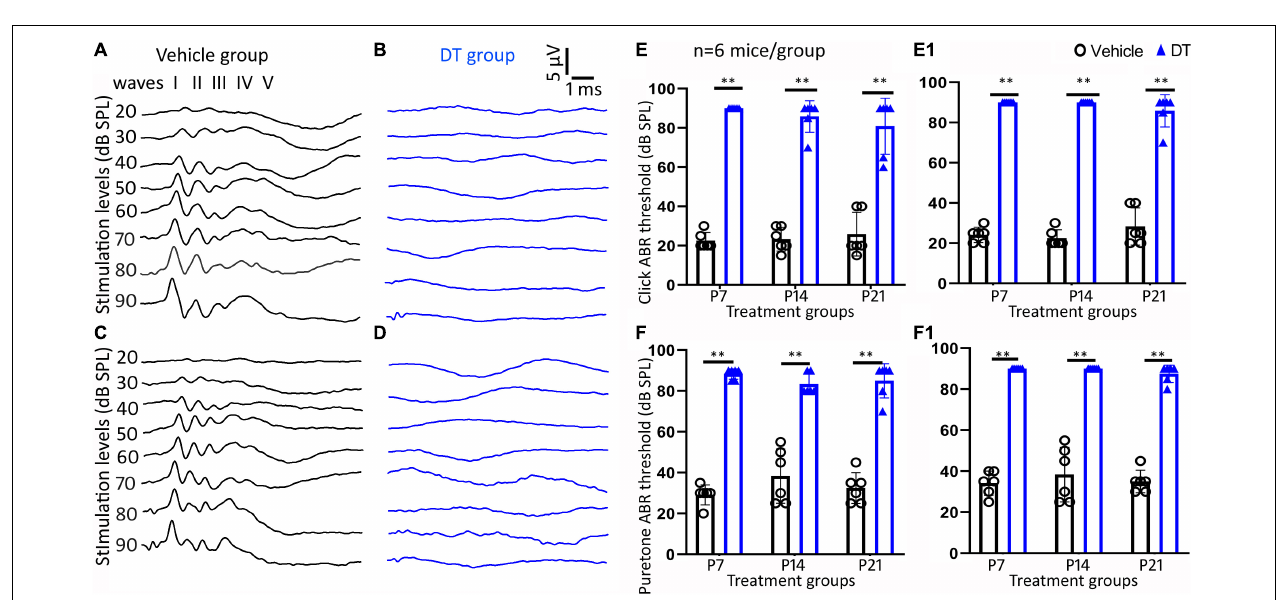
FIGURE 3 | Auditory brainstem response (ABR) measurement study. Representative ABR waveforms of the vehicle and diphtheria toxin (DT) groups are shown in (A–D) . ABR was tested on 4- (A,B) and 5-week-old (C,D) Nefl CreER / + ;iDTR + / − mice that were treated with tamoxifen on P1–P5, followed by either vehicle (A,C) or DT (B,D) treatment. Quantitative analysis shows significant differences in click (E,E1) and pure tone (16 kHz) (F,F1) between the DT and vehicle groups in the P7, P14, and P21 treatment groups in the measurements at both 4 (E,F) and 5 weeks old (E1,F1) . ∗∗ p < 0.01 (ANOVA, n = 6 mice per group).